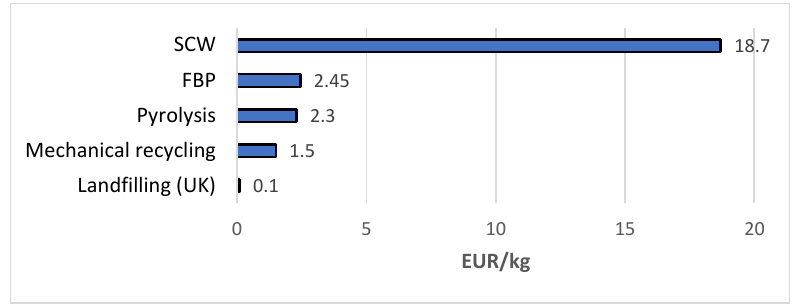
Figure 7. Comparison of recycling and landfilling cost (EUR/kg) generated by developed system.